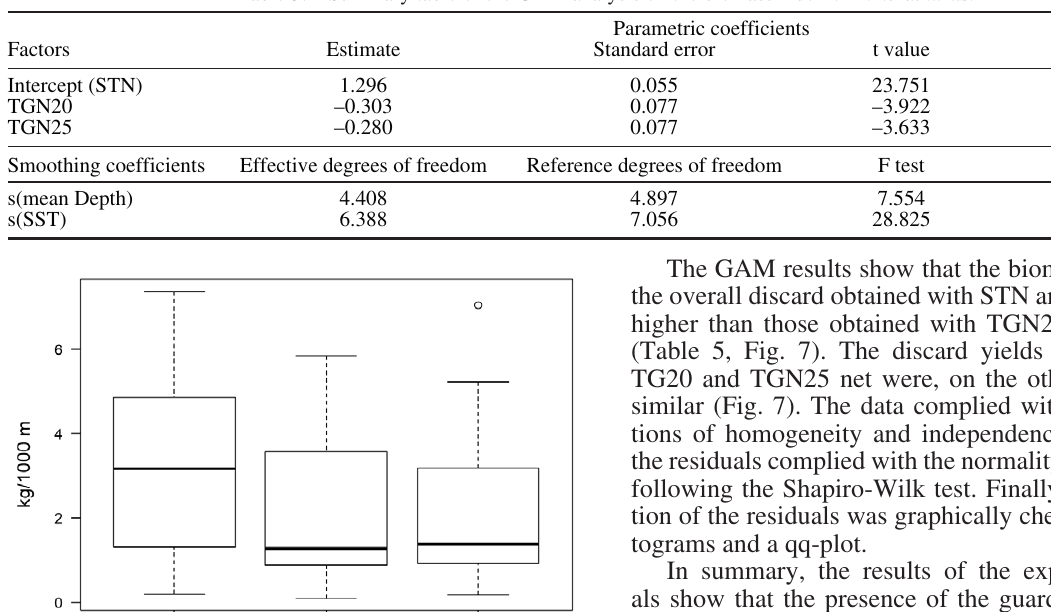
Fig. 4. – Smoothing curves estimated for the mean depth (left) and the sea surface temperature (right) by the GAM model of the biomass index of P. kerathurus . Dashed lines represent the 95% confidence intervals. Table 3. – Summary table of the GAM analysis on the biomass index of P. kerathurus.